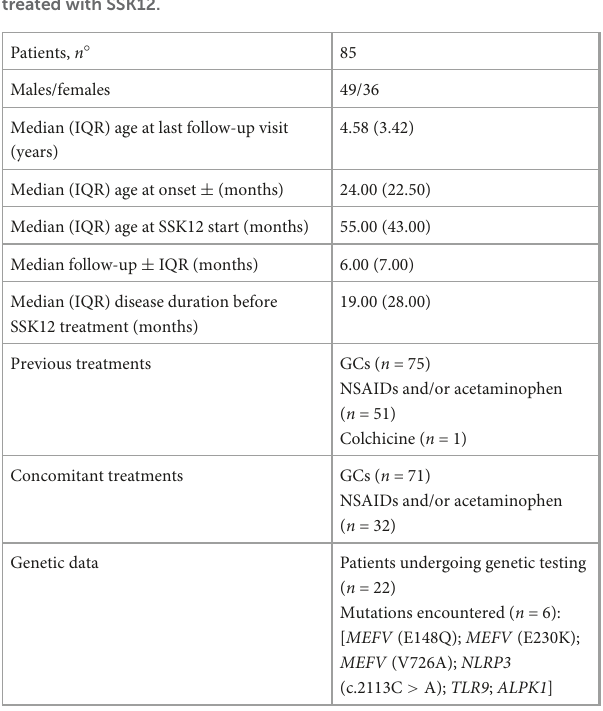
TABLE 1 Demographic and therapeutic data of the cohort of patients with PFAPA syndrome recruited from the AIDA International Registry and treated with SSK12.